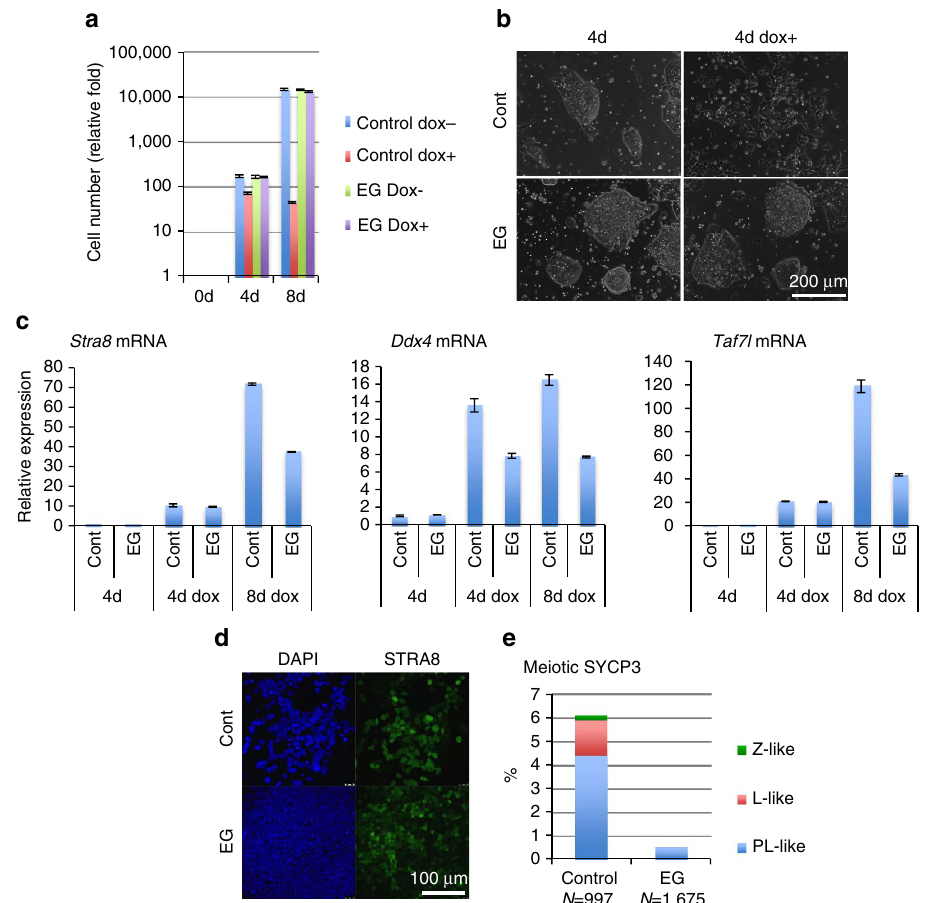
Figure 8 | Meiosis-like changes in Dox-treated Max -null ESCs with rescued viability by mutant c-MYC/MAX. ( a ) Max -null ESCs with or without mutant c-MYC/MAX, whose expression was under the control of the constitutive b -actin promoter, were treated with Dox for the indicated days, and then viable cell numbers were counted. The number of cells at day 0 (0d) was arbitrarily set to one ( n ¼ 3, means ± s.d.). ( b ) Microscopic inspection of Dox-treated and -untreated Max -null ESCs for 4 days (4d) with or without mutant c-MYC/MAX. ( c ) Examination of the expression levels of meiotic genes in Dox- treated and untreated Max -null ESCs with or without mutant c-MYC/MAX. Expression levels of Stra8 , Ddx4 and Tafl7l were examined by TaqMan-based quantitative PCR ( n ¼ 3, means ± s.d.). ( d ) Max -null ESCs with or without mutant c-MYC/MAX were treated with Dox for 8 days (8d) and then subjected to immunostaining with antibodies against STRA8. ( e ) Frequency of the meiosis-like SYCP3-staining pattern in Dox-treated Max -null ESCs with or without mutant c-MYC/MAX for 8 days. Cont,